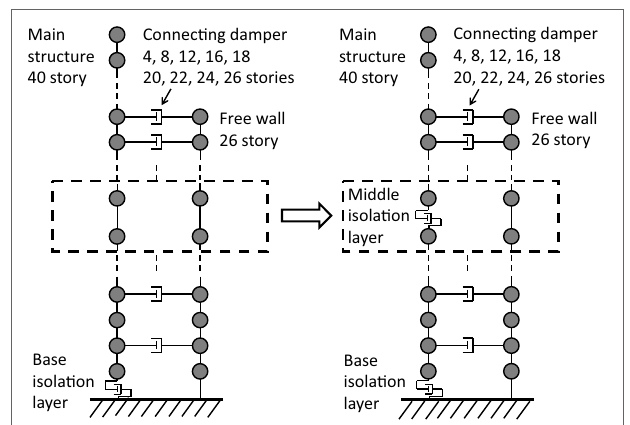
FIGURE 1 | Transformation of base-isolated and building connection model into multiple isolation and building connection model